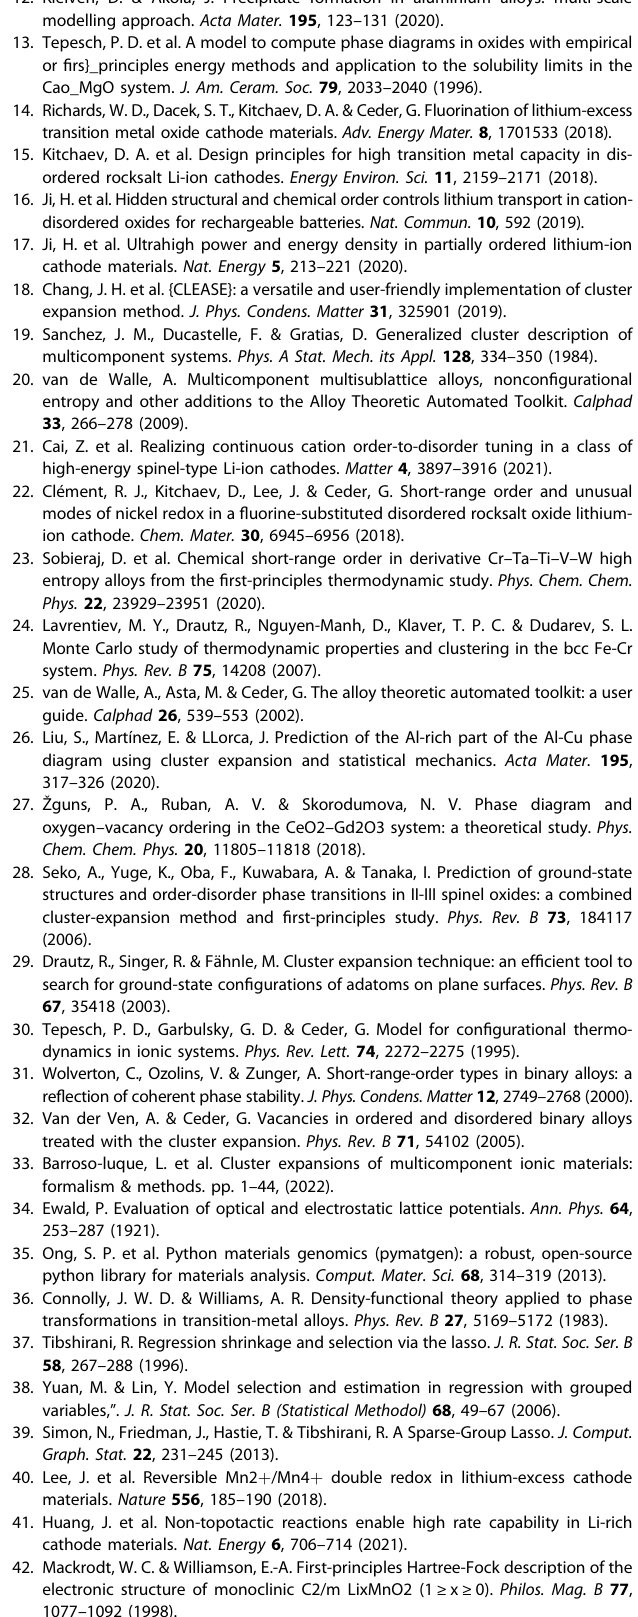
Algorithm overview . Deviating from the algorithm described in